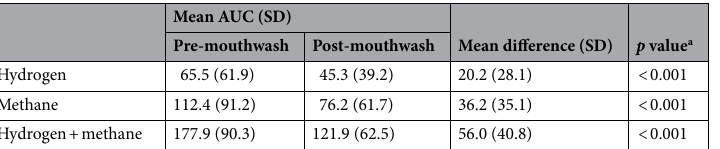
Table 5. Comparison of area-under the curve (AUC) pre versus post-mouthwash (n = 69). a Paired t-test. AUC area under the curve; SD standard deviation.